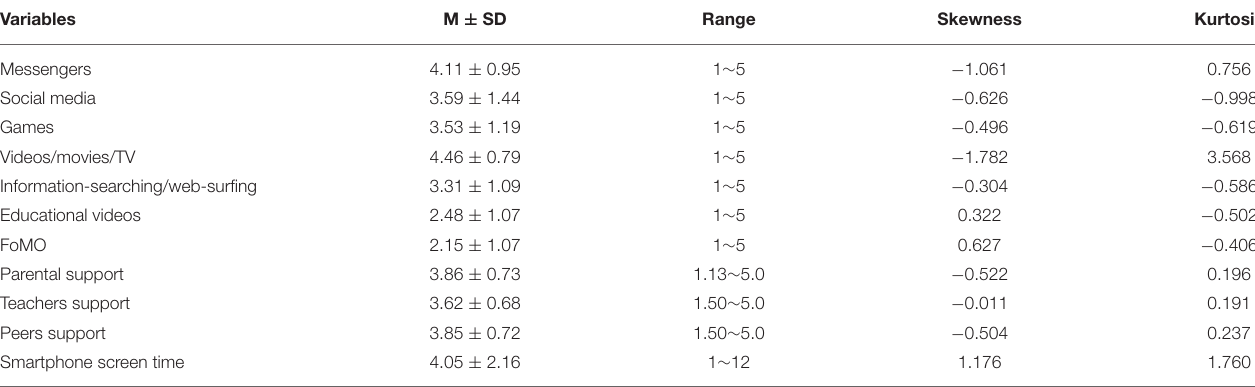
TABLE 2 | Intrapersonal, interpersonal factors, and smartphone screen time ( N =